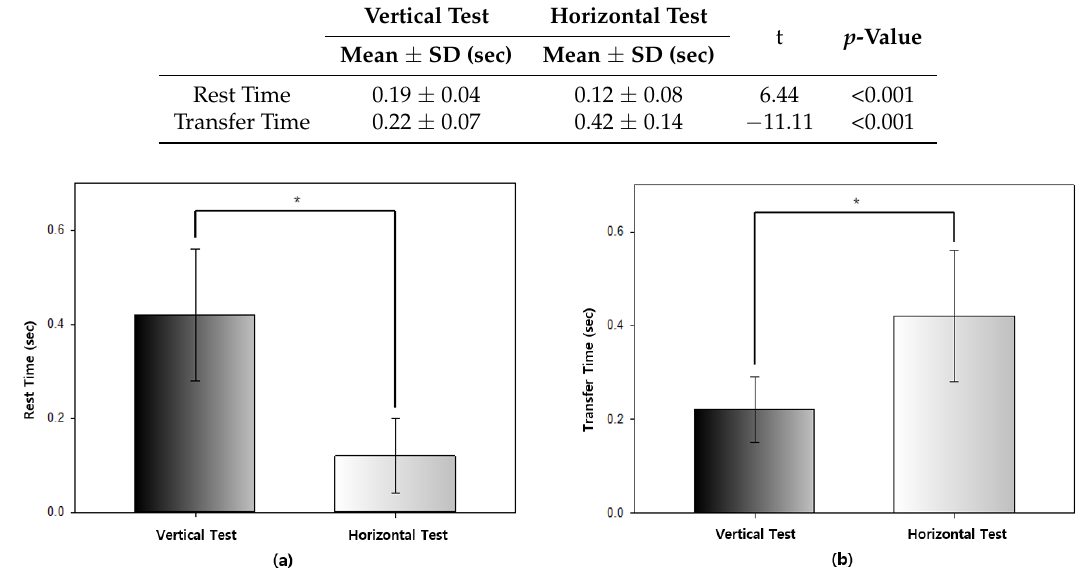
Figure 9. Chart comparisons of the rest time and transfer time: ( a ) Rest time; ( b ) Transfer time.